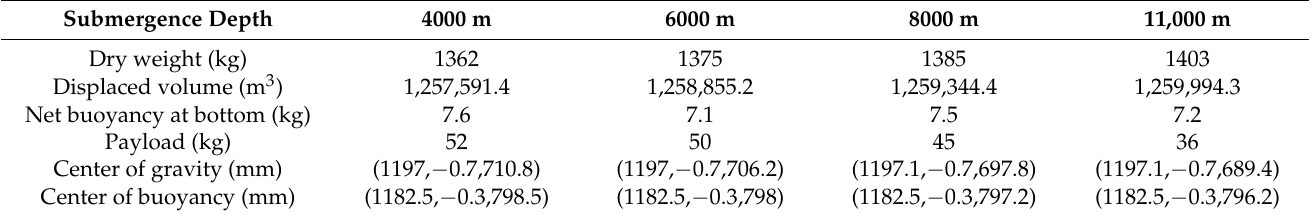
Table 1. The hydrostatic parameters for operating conditions of various diving depths.